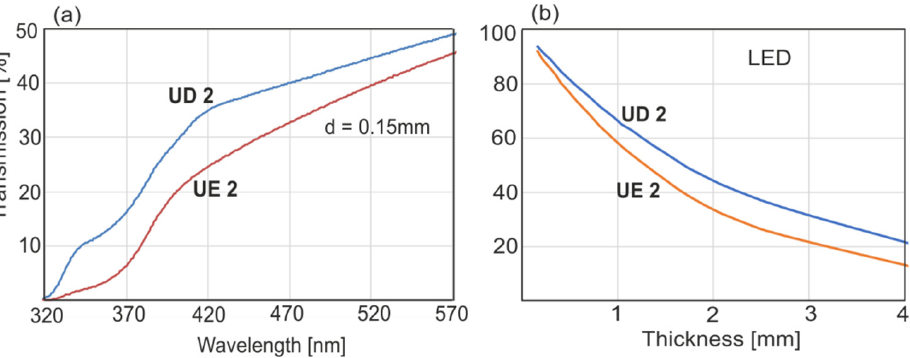
Figure 6. Spectrophotometric characteristics: ( a ) Resin transmission. ( b ) Light transmission with a small distance between the light source (LED, λ = 460 nm) and detector as a function of layer thickness.